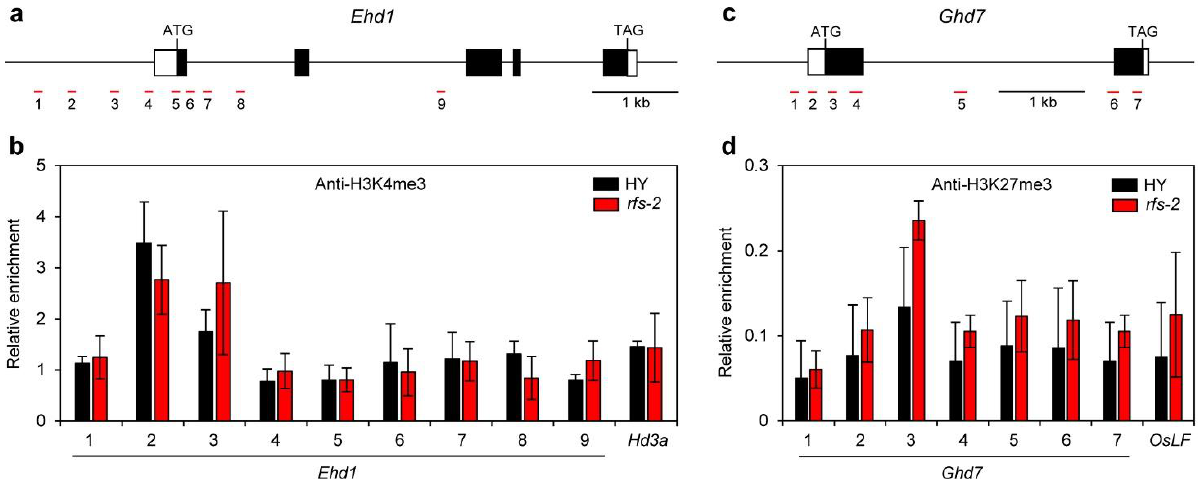
Figure 5. Histone modification patterns of differentially expressed genes in the rfs-2 mutant. ( a , c ) Schematic representation of Ehd1 ( a ) and Ghd7 ( c ) loci. White and black boxes indicate untranslated regions and exons, respectively. Thick and thin black bars represent promoter and intron regions, respectively. Short red lines with numbers (1–9 for Ehd1 and 1–7 for Ghd7 ) represent genomic DNA regions eluted from the protein–DNA complexes. The primers used for qPCR analysis of fragments are listed in Supplemental Table S1. Black scale bars = 1 kb. ( b , d ) Chromatin immunoprecipitation (ChIP) analysis of the H3K4me3 level on Ehd1 ( b ) and the H3K27me3 level on Ghd7 ( d ) in the 9-week-old HY and rfs-2 plants grown in LD conditions at ZT1. Hd3a and OsLF were used as positive controls for the H3K4me3-enriched locus and the H3K27me3-enriched locus, respectively [18,25,27]. Means and standard deviations were obtained from three biological replicates. Experiments were repeated three times with similar results.